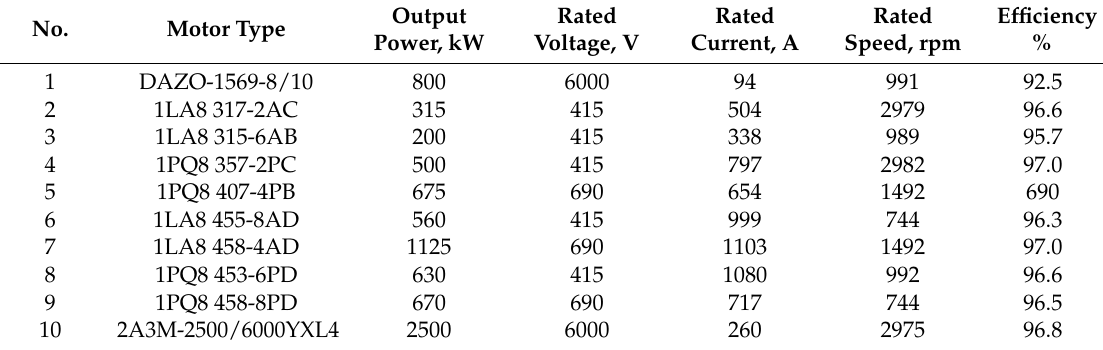
Table A1. Technical specifications of the induction motors used in the analysis [17], [20] and [21].